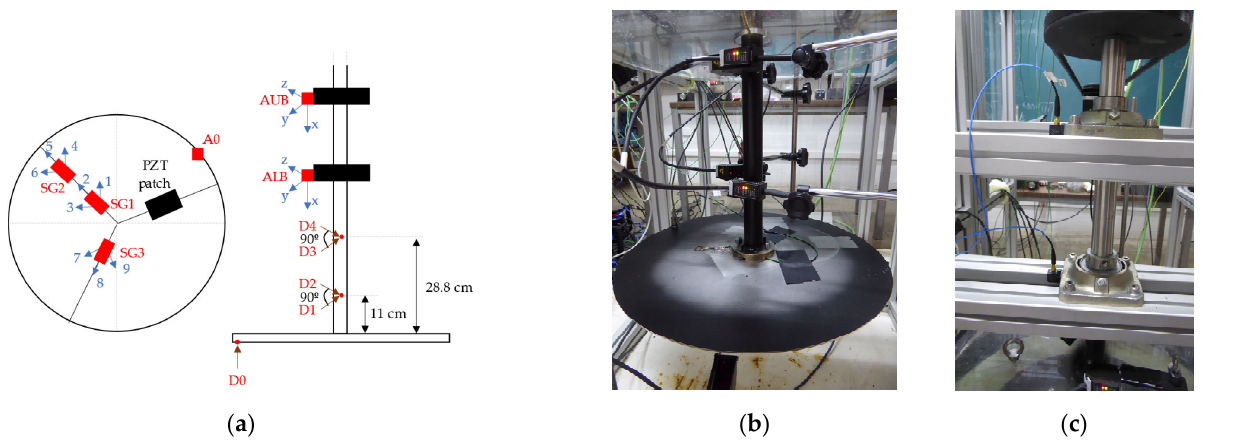
Figure 3. ( a ) Scheme of the position of the instrumentation used during the tests (bottom and lateral views). ( b ) Laser displacement sensors mounted on the shaft. ( c ) Triaxial accelerometers mounted on the lower and upper housings of the bearings.